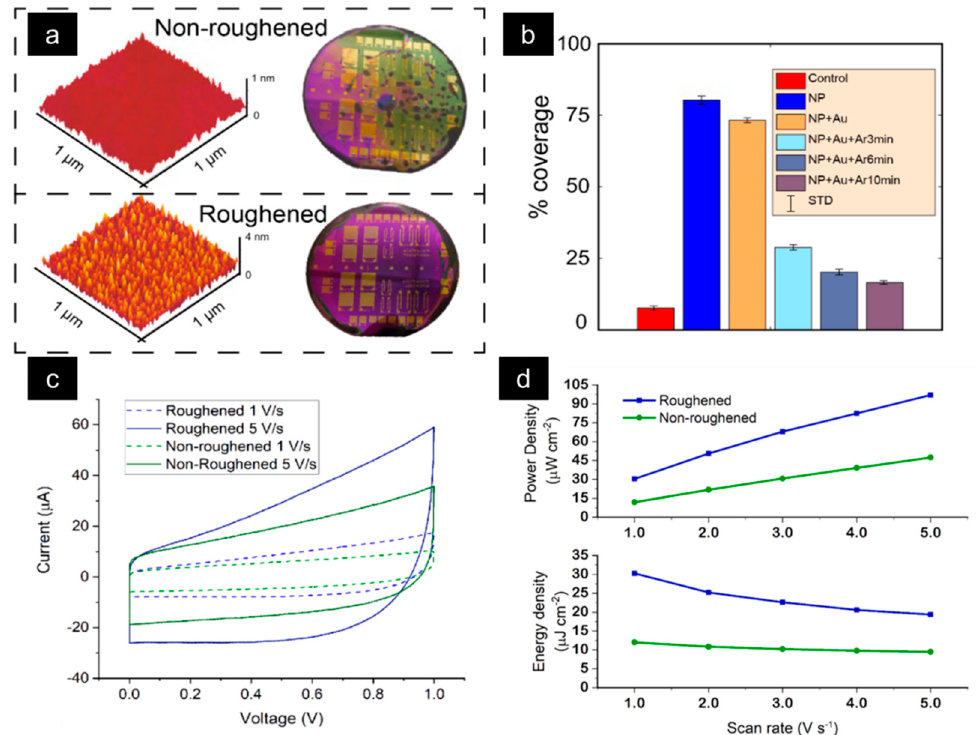
Figure 4. ( a ) AFM comparison of roughened and non-roughened sample surfaces along with optical microscopy images showing the coverage of the electrode spin-coating. ( b ) rGO spin-coated chips under different design variations (percentages of surface coverage evaluated from the optical microscopy images). Note that all roughened samples outperform the non-roughened. ( c ) Cyclic voltammograms, and ( d ) energy and power densities of the fabricated roughened and non-roughened MSCs with 1-Ethyl-3-methylimidazolium Bis(trifluoromethanesulfonyl)imide (EMIM-TFSI) electrolyte.